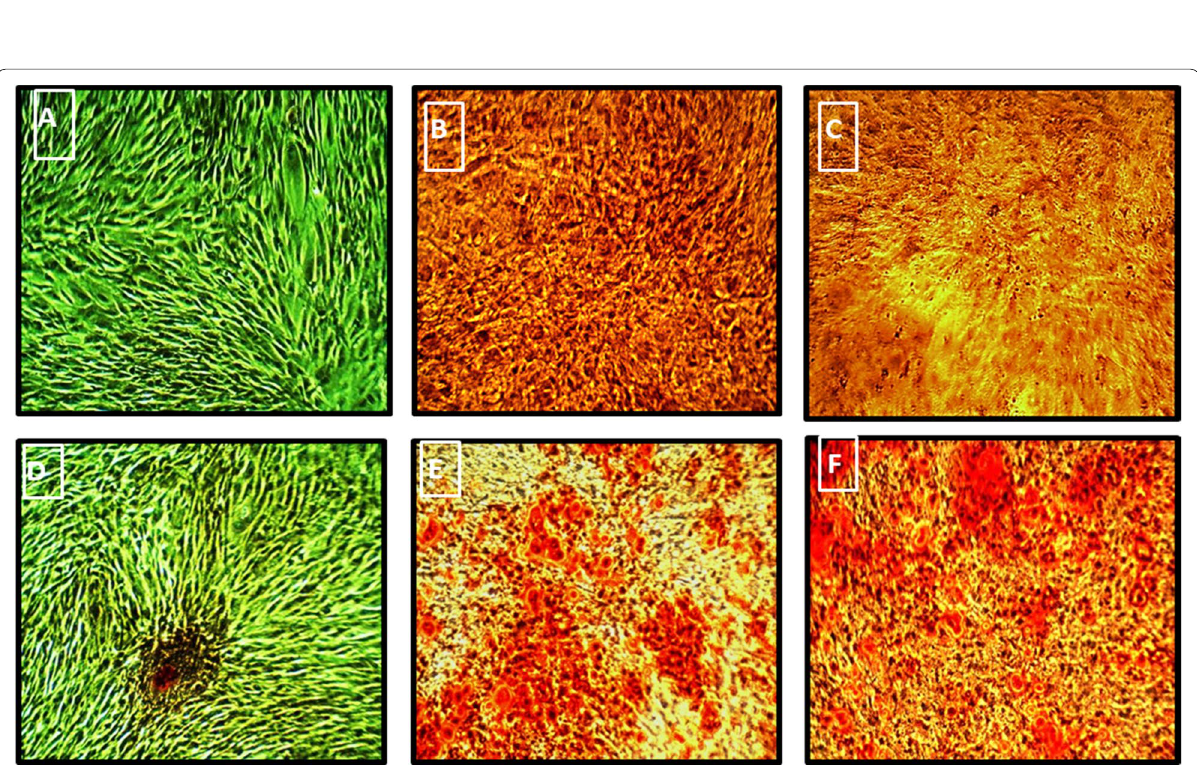
Fig. 2 Characterization of the osteogenically differentiated DP‑MSCs in the osteogenic differentiated media by Alizarin Red staining on the 14 and 28 days. Unstained control DP‑MSCs on the 14th day ( A ). Control showed faint orange stained spot at 28th day ( D ). Represented photos for staining in the osteogenic field on the 14th day ( B ). Moderate Alizarin staining in between the induced cells ( C ). Strong staining pattern in peripheries ( E ). Strong Alizarin staining on the 28 th day, in the osteogenic set in between the induced cells. ( F ) Strong Alizarin staining in the periphery of the osteogenic plate. Magnification power ×